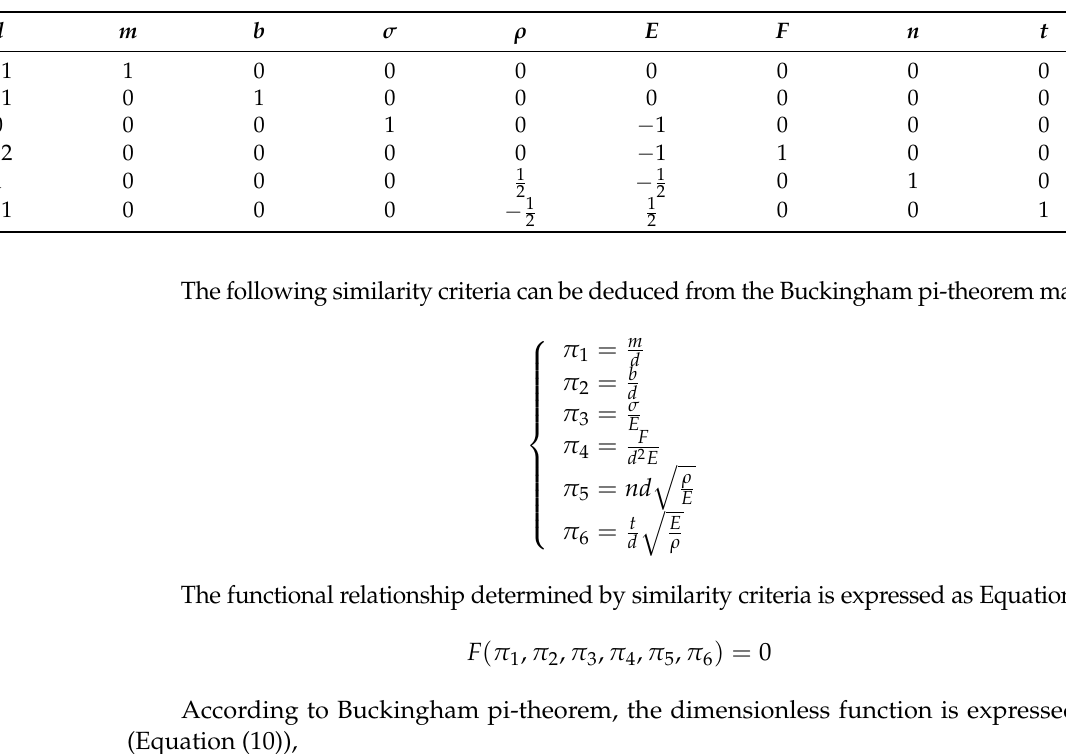
Table 4. Buckingham pi-theorem